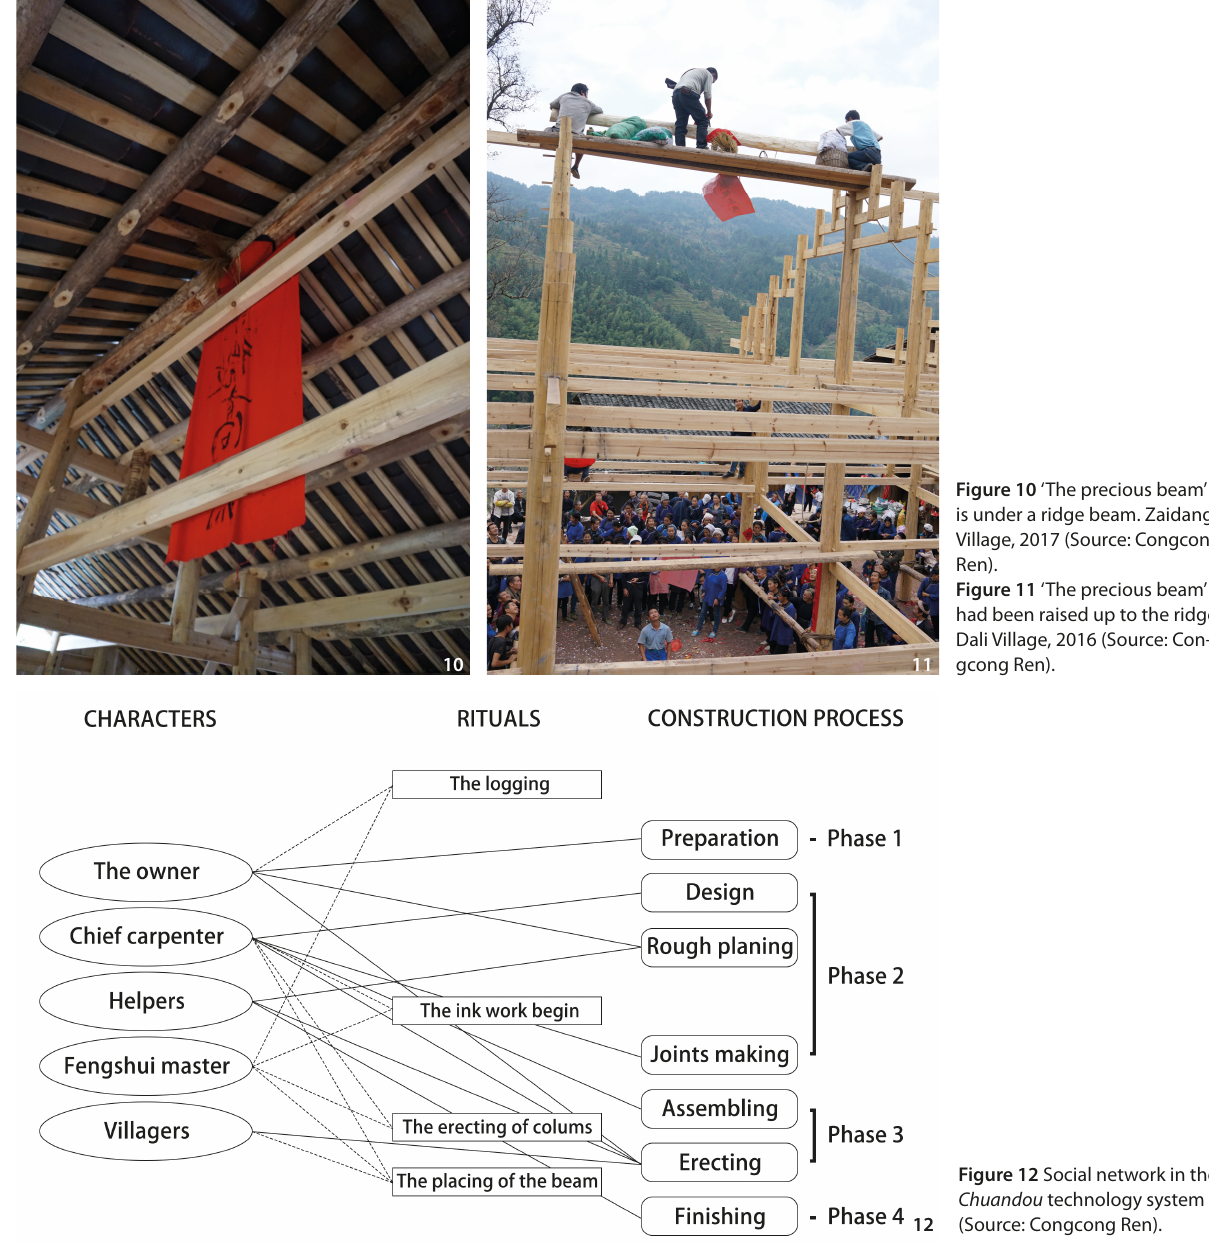
Figure 12 Social network in the Chuandou technology system (Source: Congcong Ren).